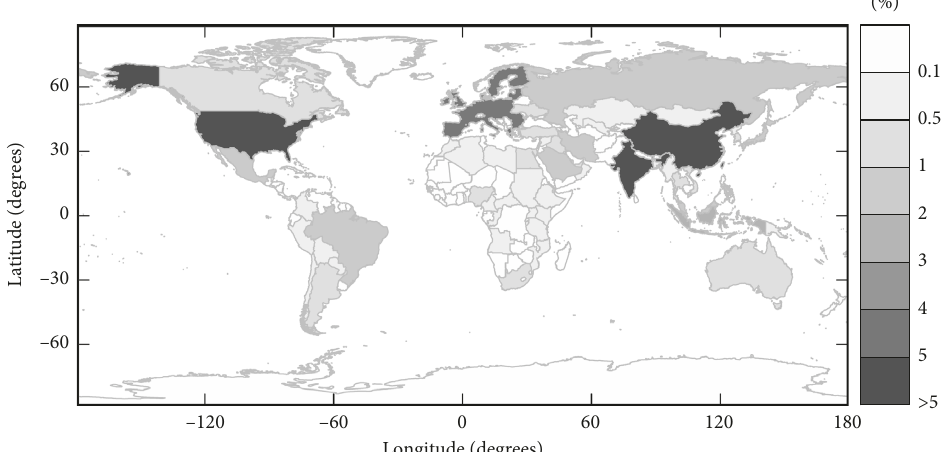
Figure 1: National emissions under Intended Nationally Determined Contribution (INDC) scenarios for unconditional pledges in 2030. The emission target data of each country are calculated based on national INDCs in this study (see Section 2.1 and Supplementary Table S1). Emission level for each country is expressed as a percentage of total global emissions in 2030. The member states of European Union (EU) are shown as a whole as their emission target is submitted for the whole region.